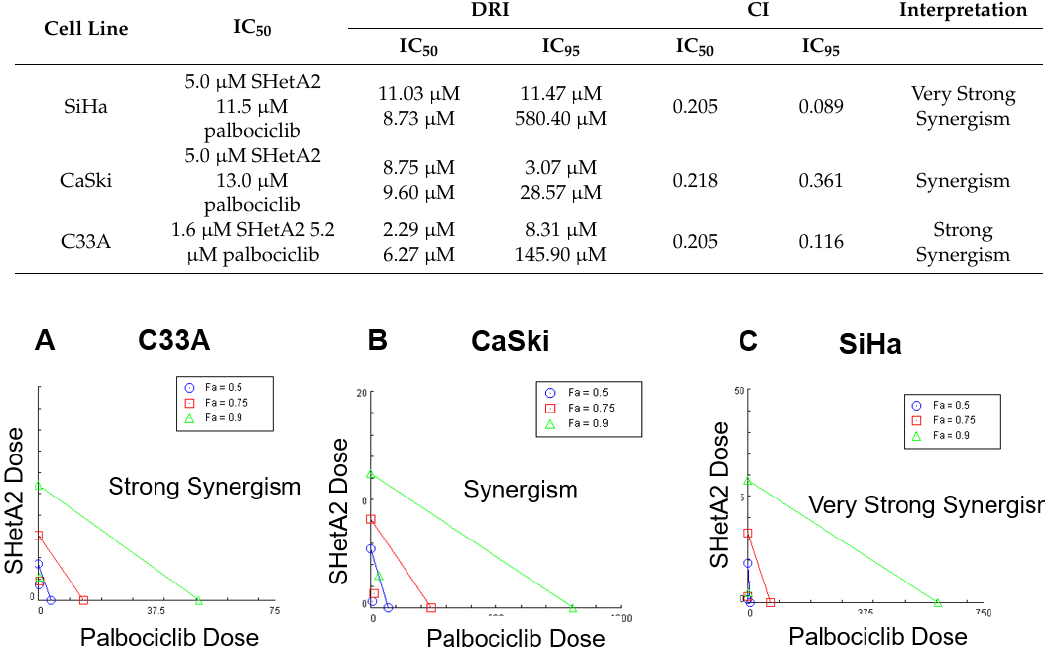
Figure 1. Isobolograms of SHetA2 and palbociclib treatment on ( A ) C33A, ( B ) CaSki, and ( C ) SiHa cervical cancer cell lines.